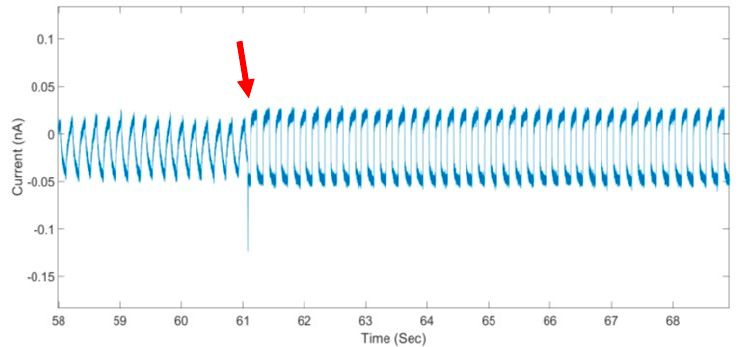
Figure 3. Formation of a lipid bilayer pointed by the arrow, here the bilayer formed 61 s after applying the